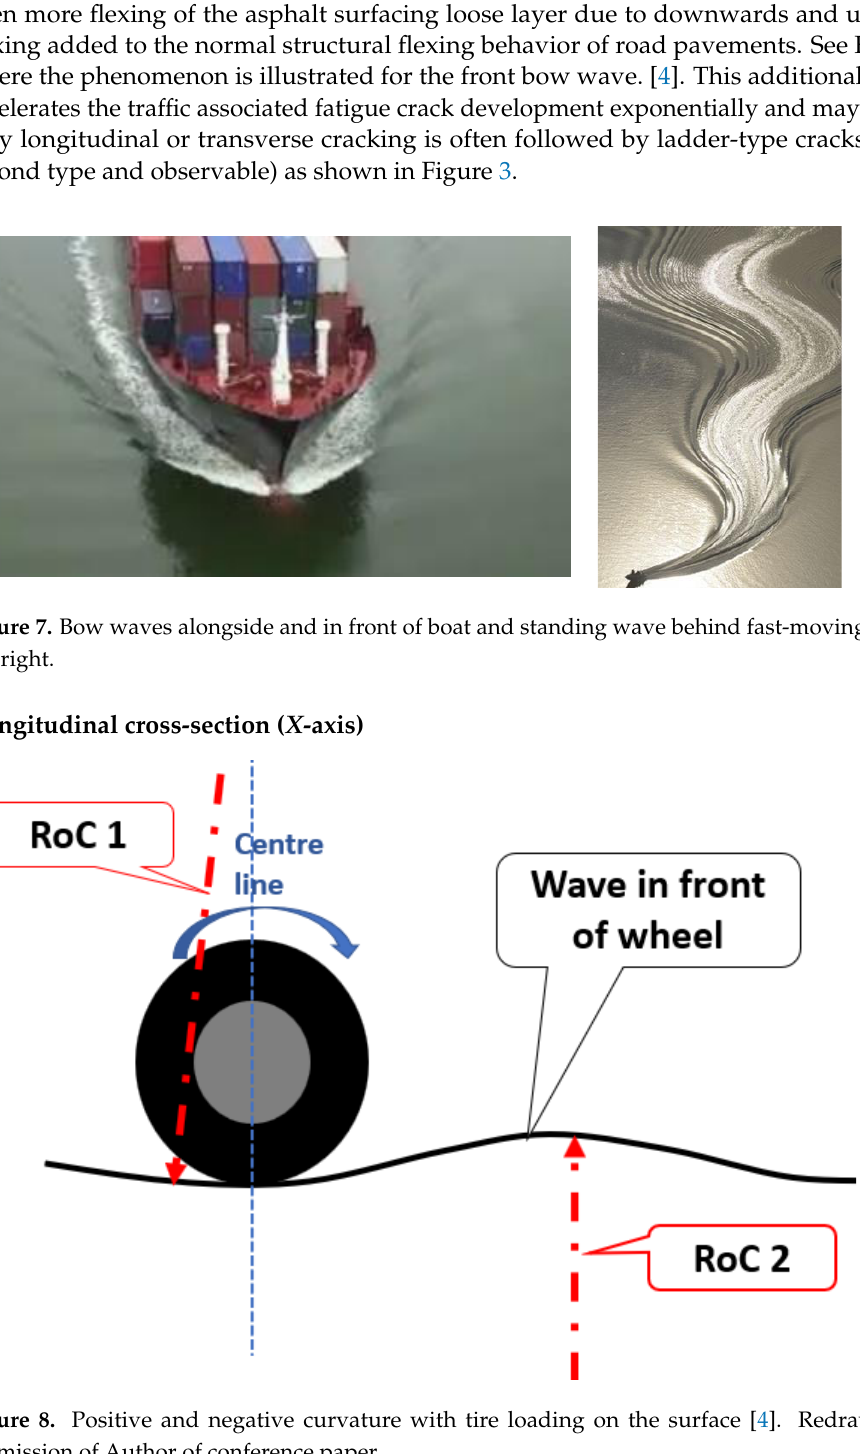
Figure 8. Positive and negative curvature with tire loading on the surface [4]. Redrawn with permission of Author of conference paper